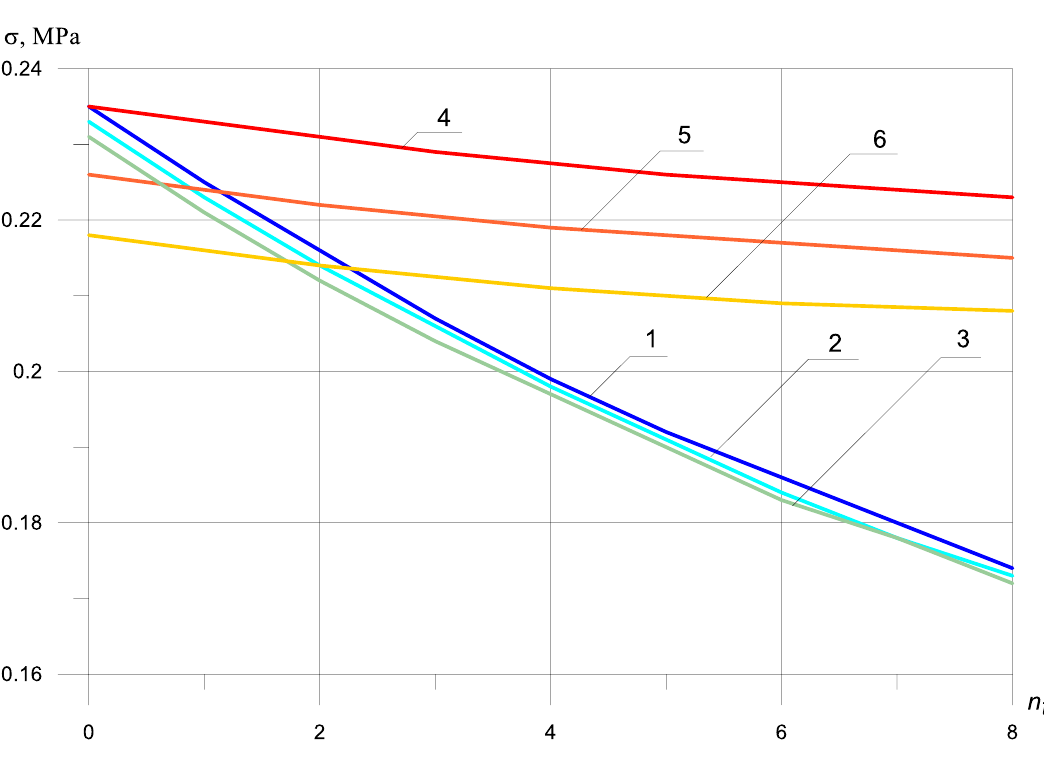
Figure 4. Dynamic stresses without bimodularity, depending on the number of bars in the zone under tension taking into account the beam mass: (1) σ t at n c = 0; (2) σ t at n c = 2; (3) σ t at n c = 4; (4) σ c at n c = 0; (5) σ c at n c = 2; (6) σ c at n c =